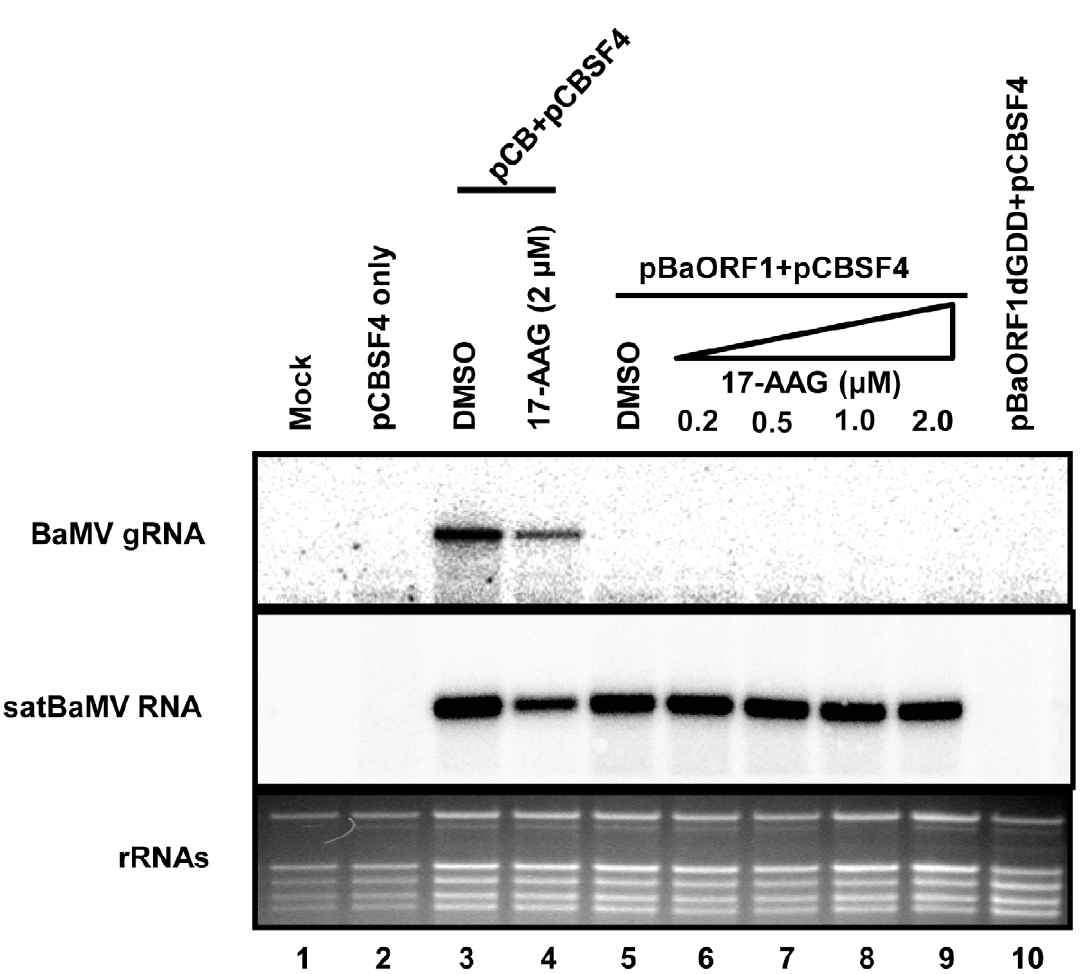
Figure 5. Effect of 17-AAG on satBaMV RNA accumulation in protoplasts. Northern blot analysis of total RNA prepared from inoculated N. benthamiana protoplasts at 24 hpi. The protoplasts were inoculated with various combinations of helper and satBaMV RNA constructs in the absence or presence of 17-AAG as indicated at the lane headings. RNA was extracted at 24 hpi, separated by electrophoresis and probed with 32 P-labeled RNA transcripts complementary to the 3 9 -end of positive-stranded BaMV RNA and satBaMV RNA in the absence or presence of 17-AAG, respectively. The positions of BaMV genomic RNA (gRNA) and satBaMV RNA are indicated on the left. pCBSF4, satBaMV RNA construct; pCB, BaMV infectious clone; pBaORF1, BaMV ORF1-expressing construct; pBaORF1dGDD, defective BaMV ORF1-expressing construct, with the GDD motif of ORF1 protein deleted.